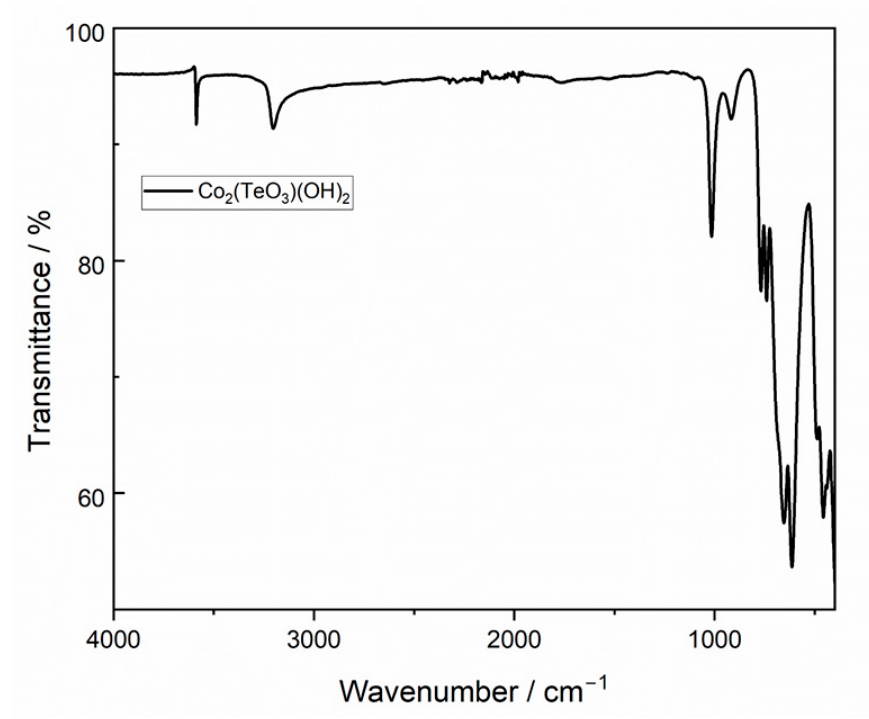
Figure 7. IR spectrum of Co 2 (TeO 3 )(OH) 2 .